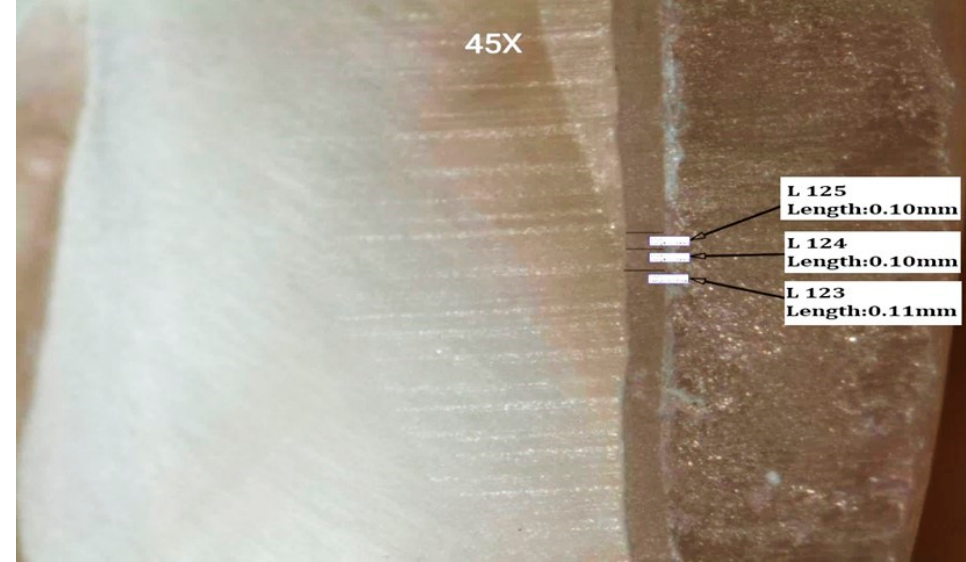
Figure 4. Stereomicroscopic view (45X) represents marginal and internal fit of a sectioned specimen at mid buccal axial wall.